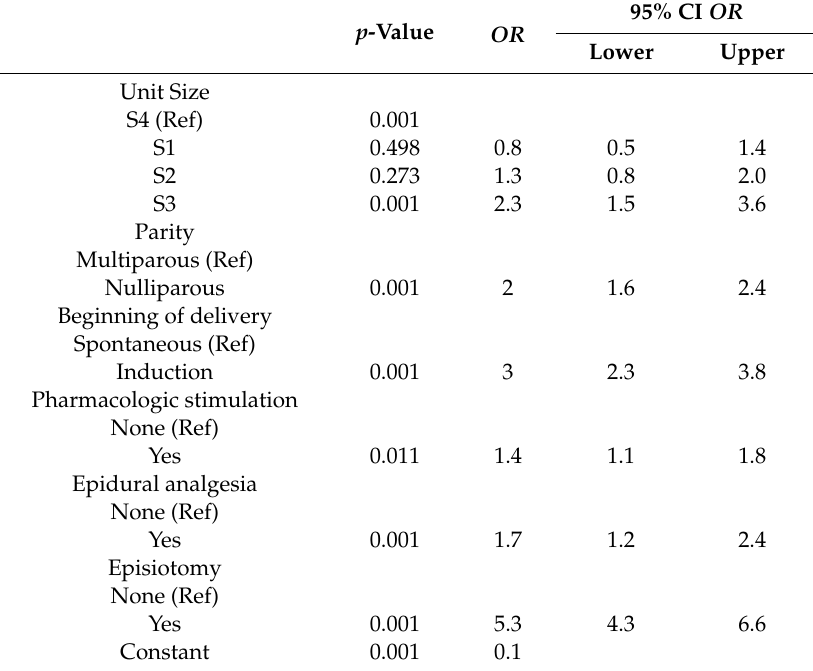
Table 4. Multivariate logistic regression of variables related to TOC ( N = 2084). p